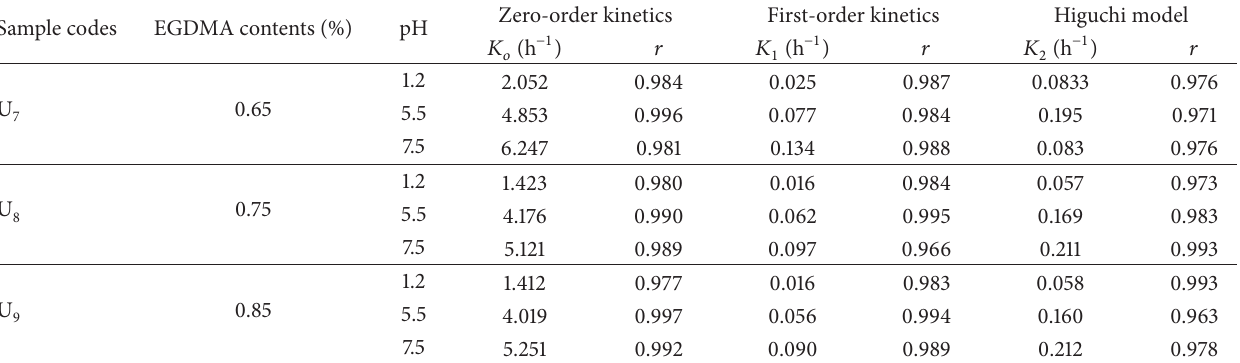
Table 7: Effect of degree of cross-linking on drug release kinetics of AA/Gelatin hydrogels in solutions of different pH values. Sample